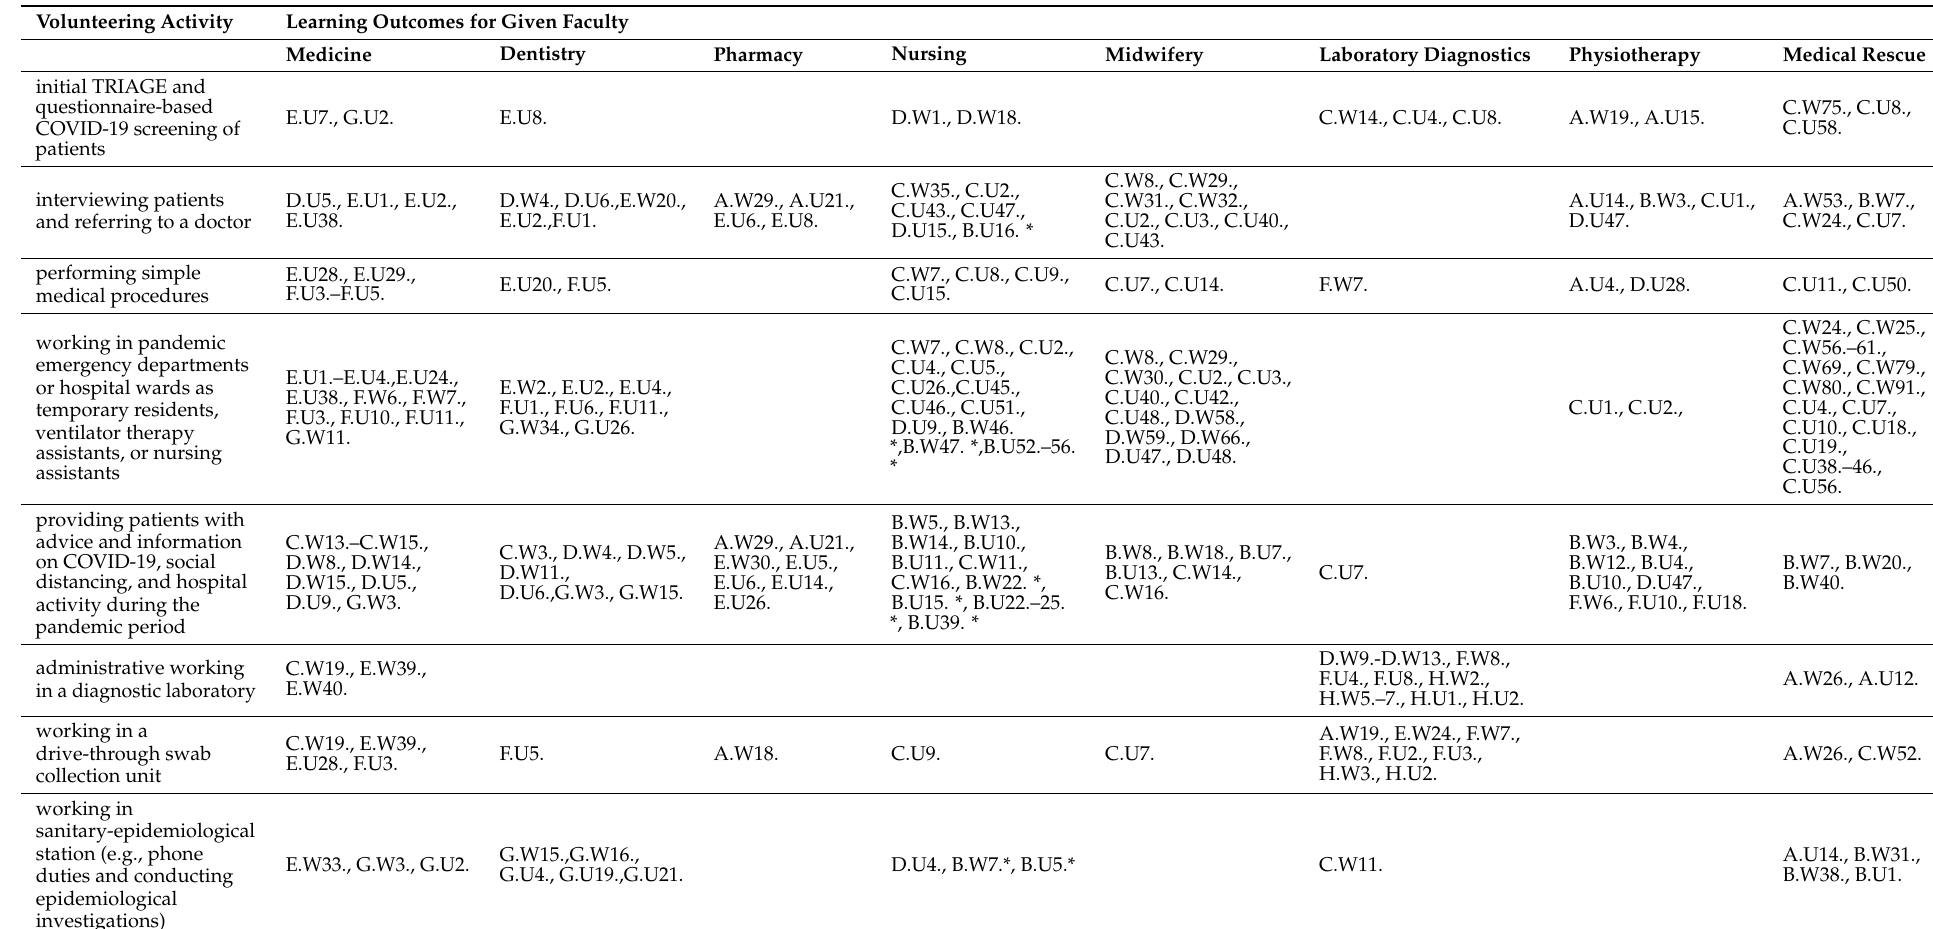
Table A1. Learning outcomes realized during the COVID-19 pandemic student